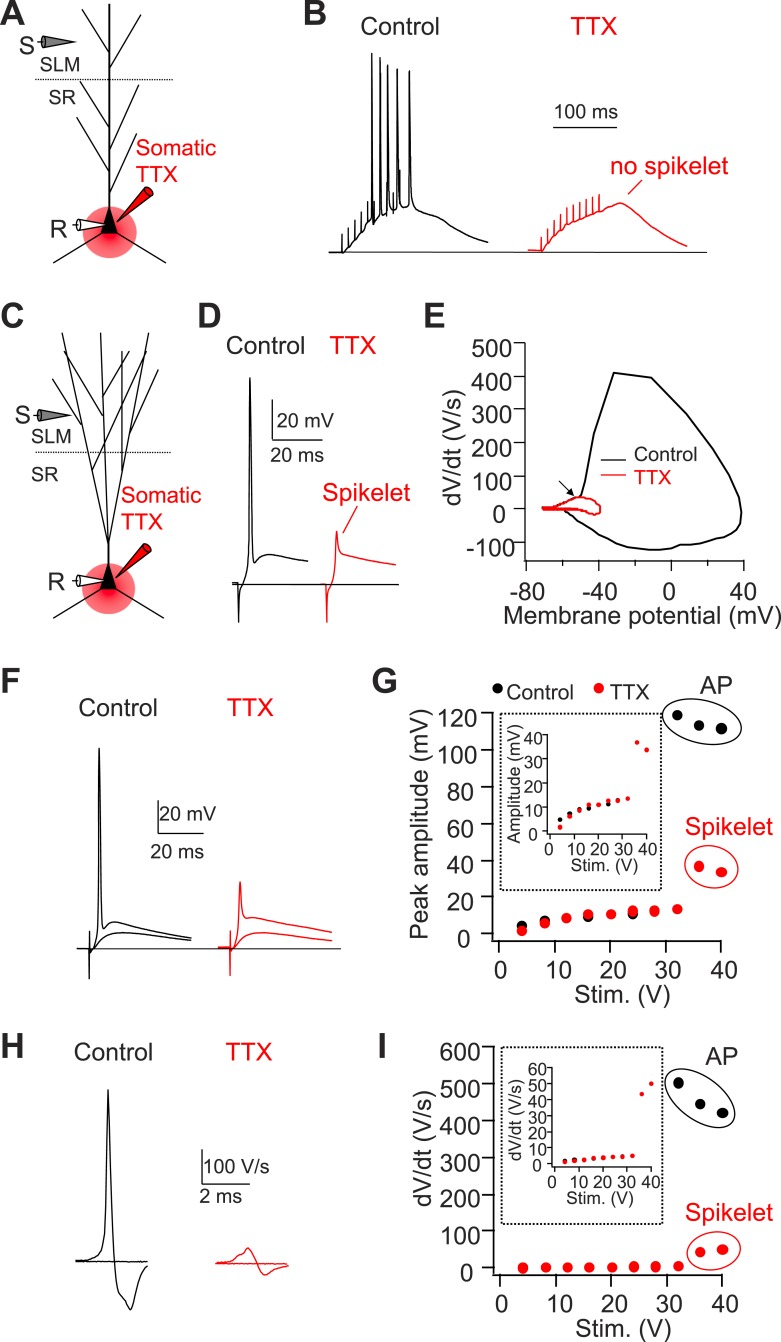
Somatic TTX application reveals prominent spikelets at the soma of CA2, but not CA1, PNs in response to PP stimulation.(A) Diagram illustrating the configuration of CA1 PN experiment as shown in (B). (B) Sample traces of somatic voltage response in a CA1 PN to high-frequency burst stimulation (100 Hz, 10 pulses) in the absence (control) or the presence of somatic TTX (somatic TTX). Note the absence of spikelets at the soma. (C) Diagram illustrating the configuration of CA2 PN experiment shown in (D–I). (D) Sample traces of somatic voltage response in a CA2 PN to a single PP stimulus in the absence (control) or the presence of somatic TTX (TTX). Note the presence of a prominent spikelet during somatic TTX application at the soma of CA2 PN. (E) A phase-plane plot from the traces shown in (D). Note the overlap of the initial rising phase in control and TTX (arrow). (F) Superimposed traces of somatic voltage response of a CA2 PN to suprathreshold and subthreshold PP stimuli in the absence or the presence of somatic TTX. (G) Input–output of somatic voltage response from the CA2 PN shown in (F). Inset shows an expanded plot of the sub-threshold somatic voltage response. Note, the spikelet amplitude reaches >35 mV, providing ∼20 mV extra somatic depolarization on top of the EPSP. (H) Sample traces of dV/dt from (F). (I) Input–output curve of dV/dt from the CA2 PN shown in (F–H). Inset shows an expanded plot of sub-threshold dV/dt. Note, dV/dt of the spikelets reaches ∼50 V/s.